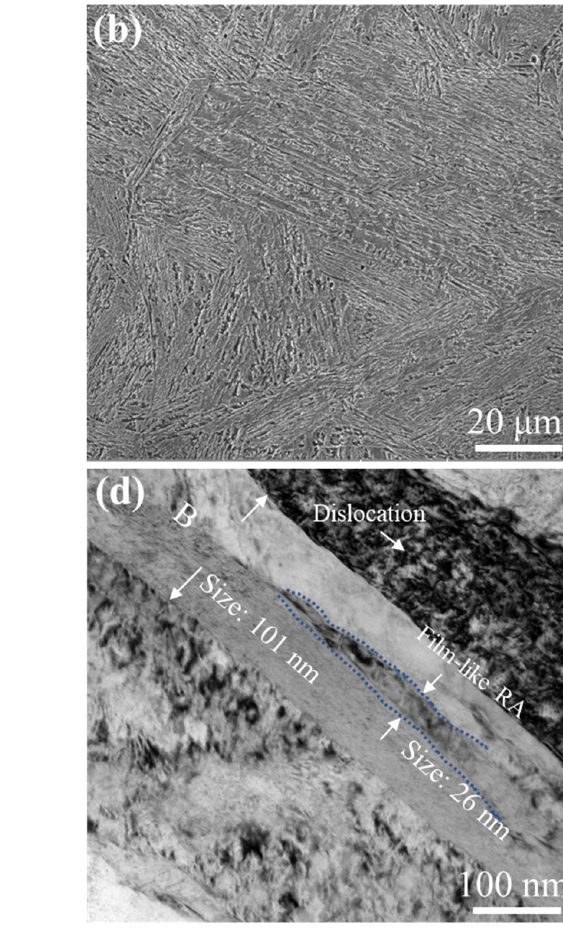
Figure 2. The original microstructures of the wheel specimens: ( a ) OM image; ( b ) SEM image; ( c , d ) TEM image.